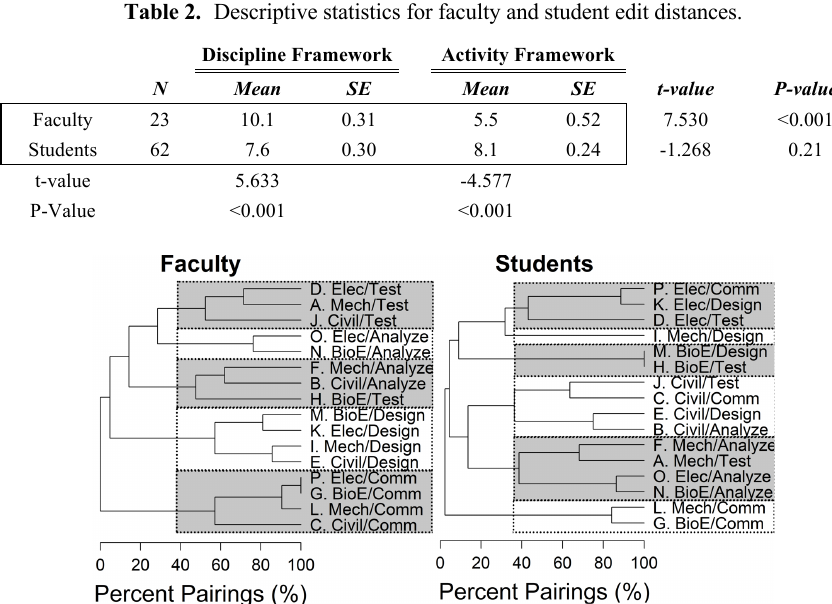
Fig. 4. Hierarchical clustering as represented by a dendrogram for faculty sorts (left) and stu- dents’ sorts (right). Faculty dendrogram branches tended to align with our engineering activity framework, while students had less consensus in their